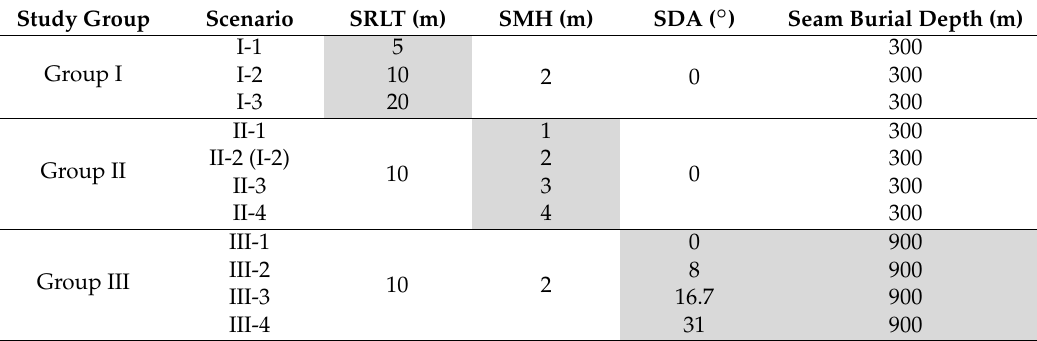
Table 1. Numerical modeling scenarios to define the influence of various stratigraphic factors on well deformations.